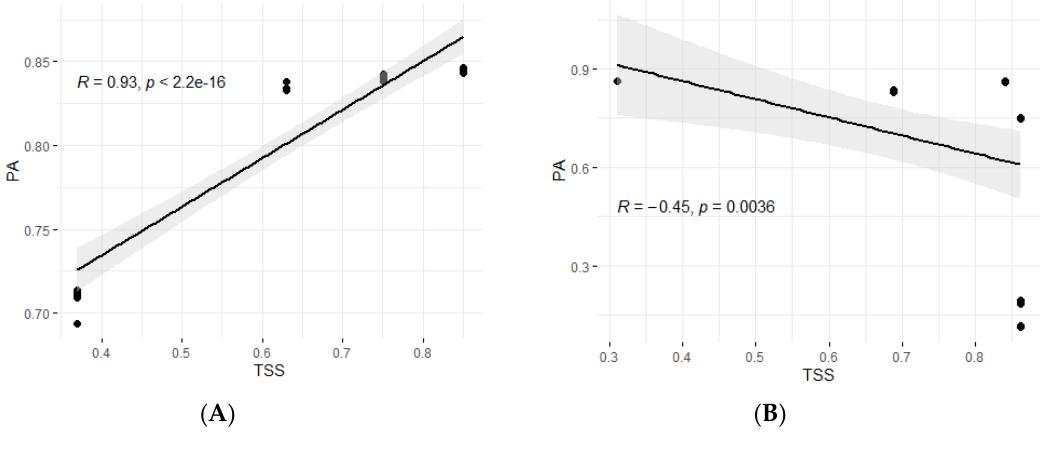
Figure 4. Pearson correlation between training set (TS) sizes and prediction accuracies (PAs) across the 10 genomic prediction algorithms conducted on RBTS ( A ) and PBTS ( B ) datasets for fall armyworm resistance (FAW) resistance.